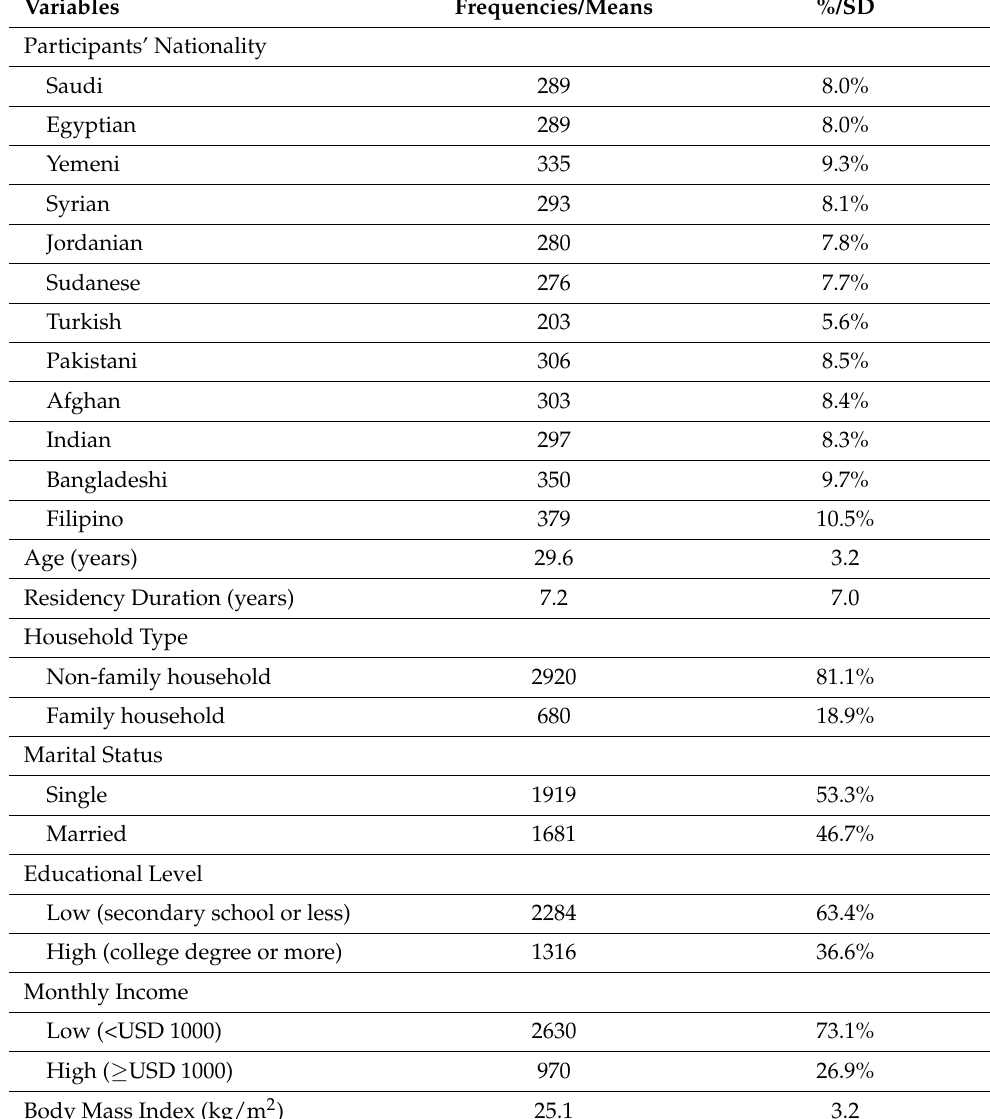
Table 1. Sociodemographic variables and body mass index of study subjects ( n = 3600).